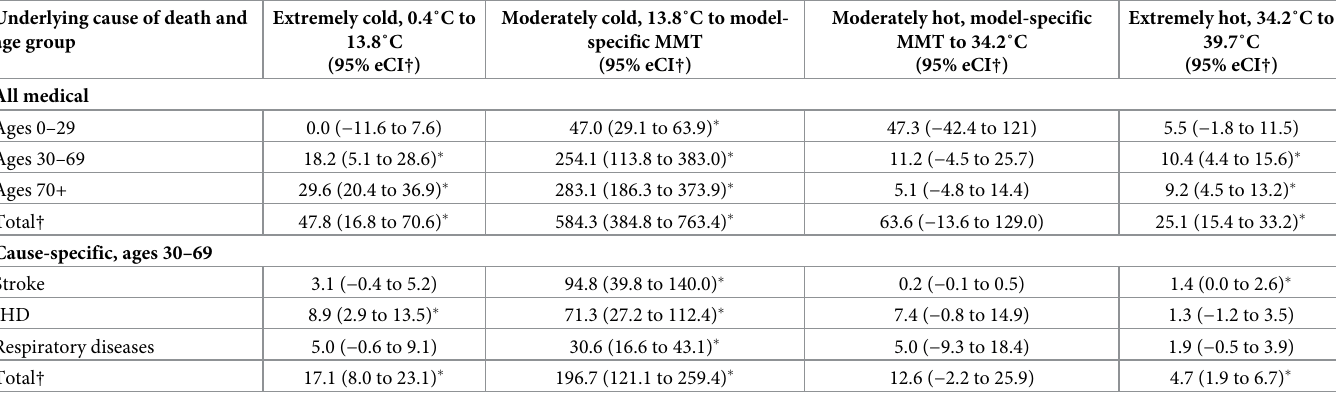
Table 2. Deaths (in thousands) attributable to hot and cold ambient temperatures in India in 2015. Underlying cause of death and Extremely cold, 0.4˚C to age group